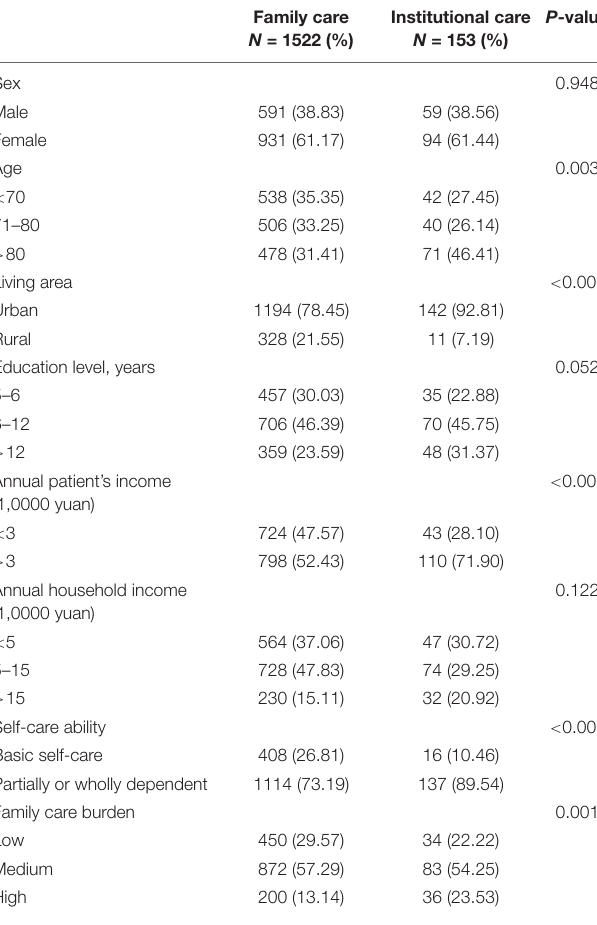
TABLE 2 | The caregiving status of the familial caregiver of patients with AD in relation to patient and caregiver characteristics ( N =